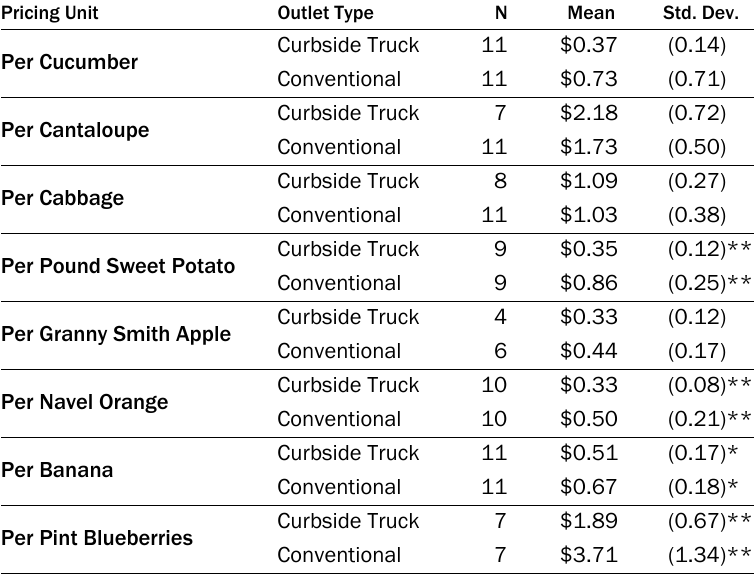
Table 4. Comparison of Prices Between Fruit and Vegetable Trucks and Supermarkets